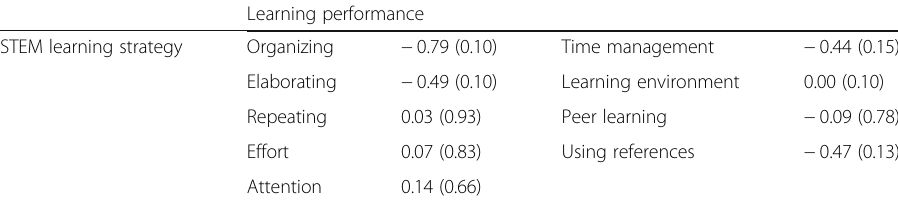
Table 3 Spearman ’ s rank correlation coefficients between learning performance and STEM learning strategy